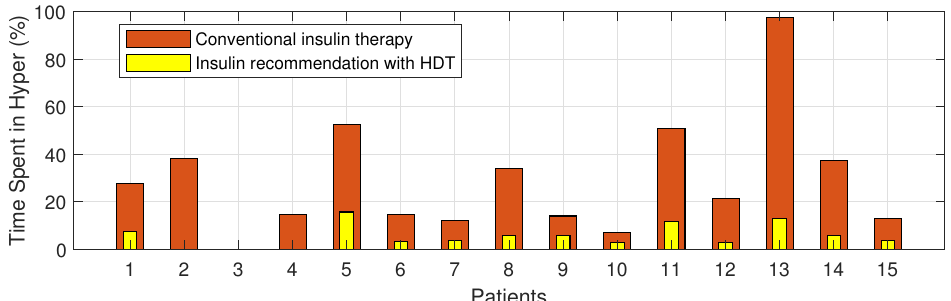
Figure 29. Percent improvement in hyper events for 15 patients with